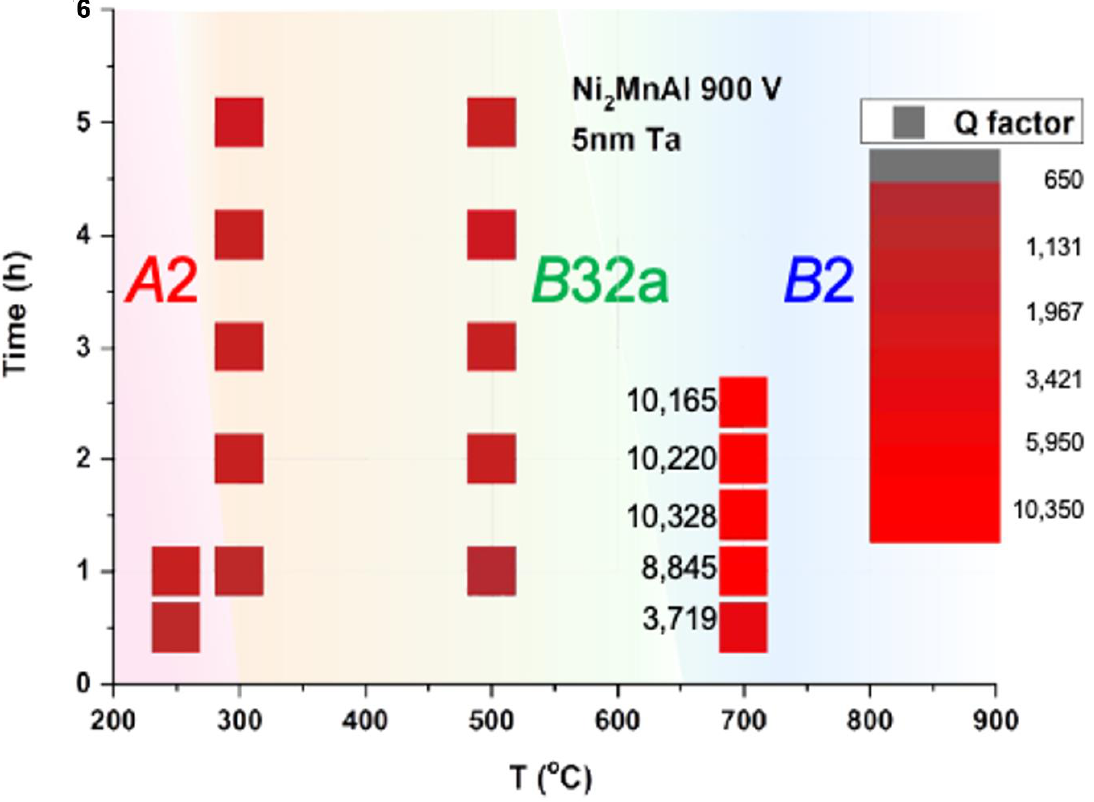
Figure 3. Crystallisation of the Ni 2 MnAl thin films indicated by Q factors, including annealing conditions which did not lead to crystallisation. The letters shown next to colour scales indicate the corresponding Q-factors.